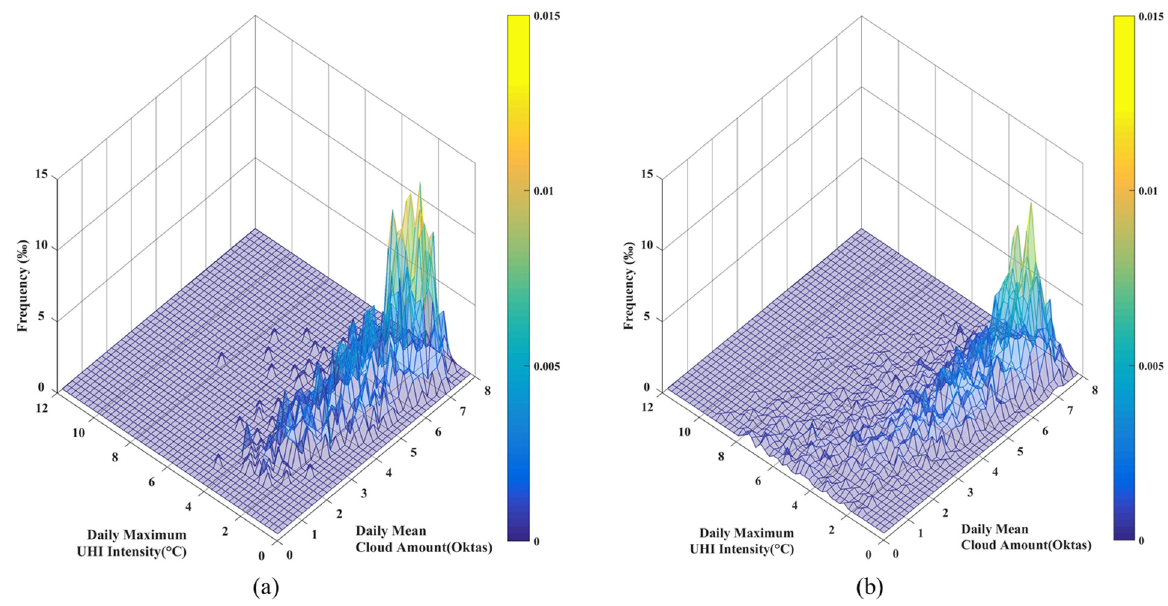
Figure 4. Frequency distribution of UHImax as a function of cloud amount (2002–2012, ( a ) summer, ( b ) annual).